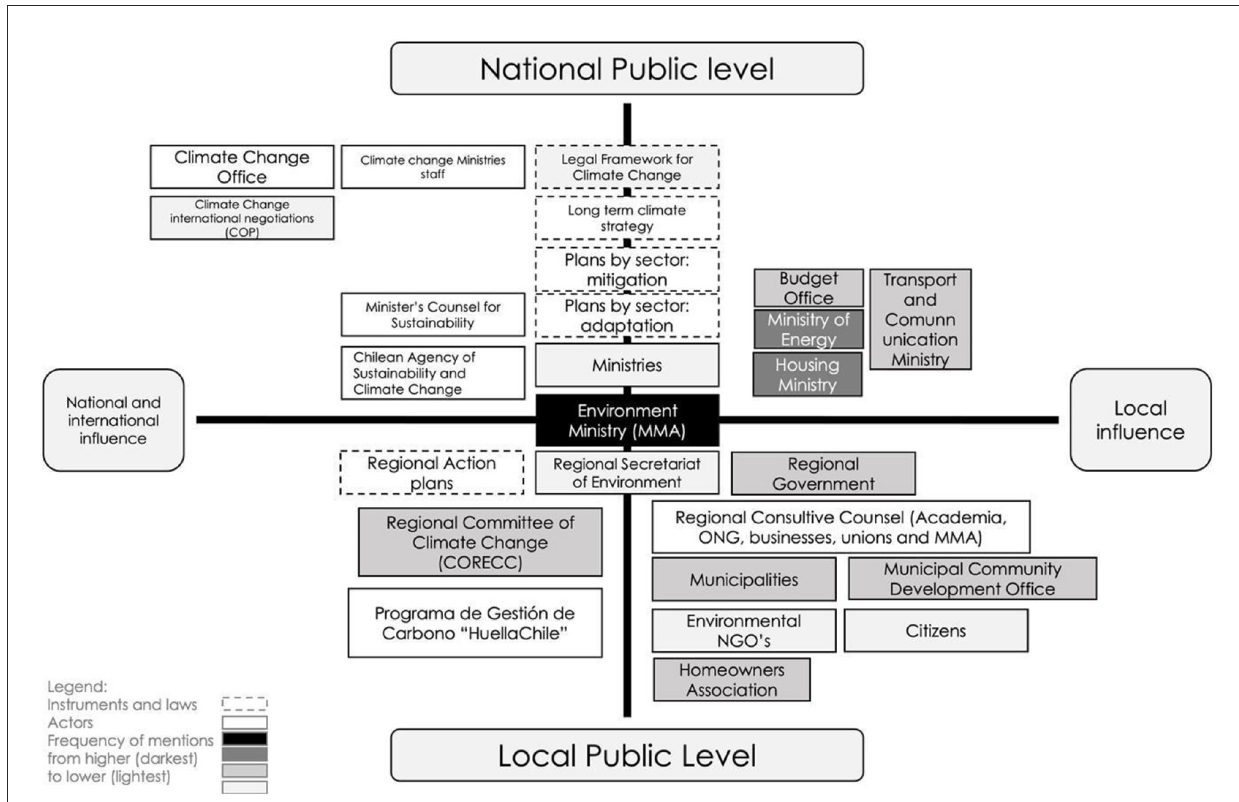
FIGURE4 Diagram of multi-scale climate governance for Chile based on normative documents and stakeholder perceptions. Source: Adapted from Centro UC de Políticas Públicas (2021), Ministerio del Medio Ambiente (MMA)